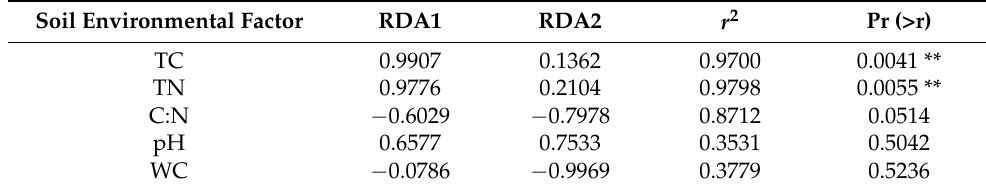
Table 3. Significance test of the correlation between environmental factors and bacterial commu- nity distribution.